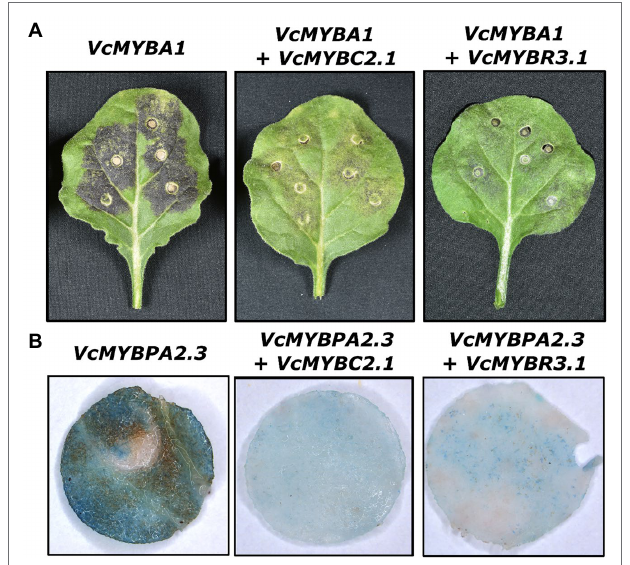
FIGURE 2 | VcMYBC2.1 and VcMYBR3.1 inhibit anthocyanin and proanthocyanidin accumulation. Representative phenotypes of Agrobacterium infiltrated Nicotiana benthamiana leaves expressing MYB activators and PpbHLH3 , and co-expressing the repressors VcMYBC2.1 or VcMYBR3.1 . The SG6 MYB activator VcMYBA1 was used for anthocyanin accumulation assays (A) while the SG5 MYB activator VcMYBPA2.3 was used for proanthocyanidin accumulation assays (B) Leaves were photographed 7 days post infiltration. For proanthocyanidin accumulation studies, 1 cm diameter leaf discs were taken and DMACA stained before being